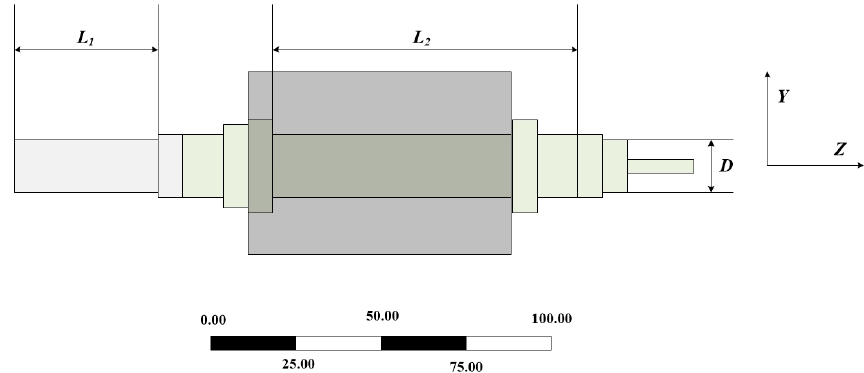
Figure 3. Design variables in the rotor optimization